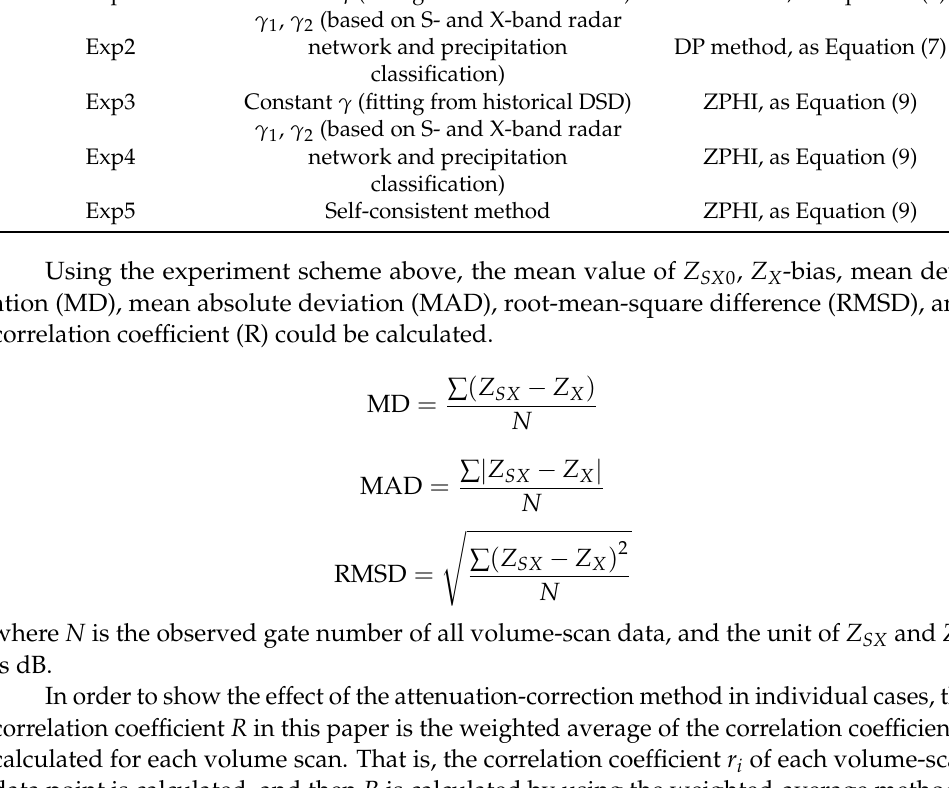
Table 3. The main characteristics of the five experiments. Method Estimation of γ Exp1 Exp2